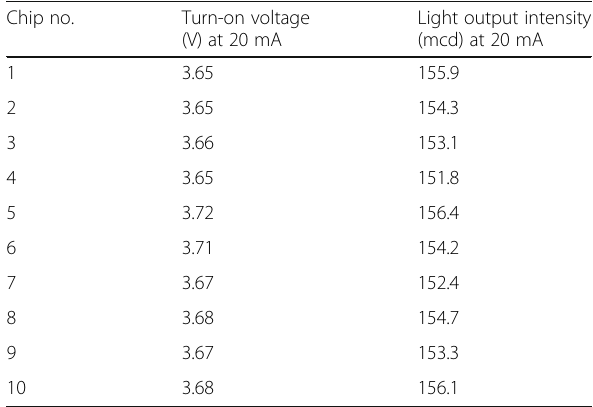
Table 1 The average turn-on voltage and light output intensity for selected chips from different position of InGaN/GaN LED wafers with the optimal PS NS arrangement (PS NS diameter of 100 nm and period of 100 nm) on an ITO window layer under a 20-mA driving current Chip no.